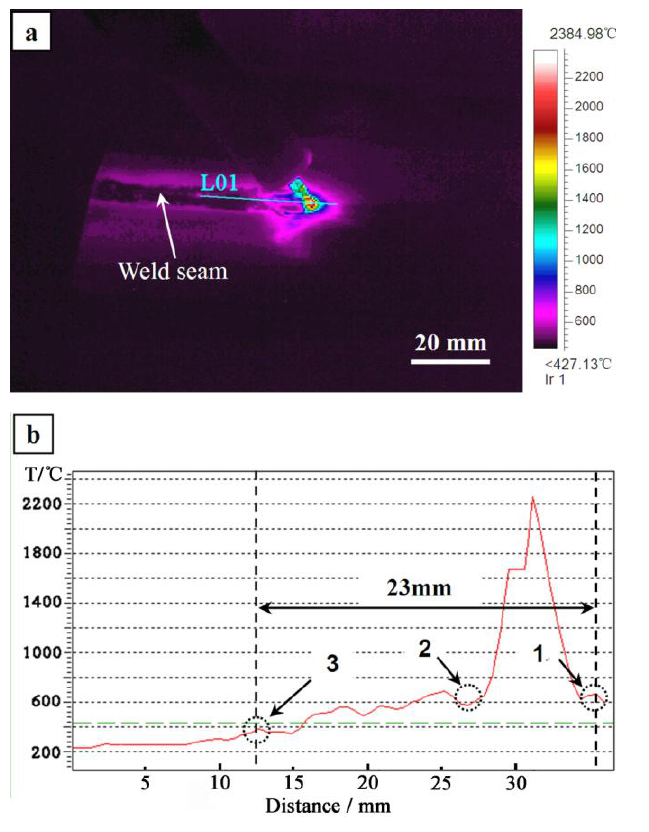
Figure 5. IR image at the welding process: ( b ) the temperature curve of Line 01 (L01) in ( a